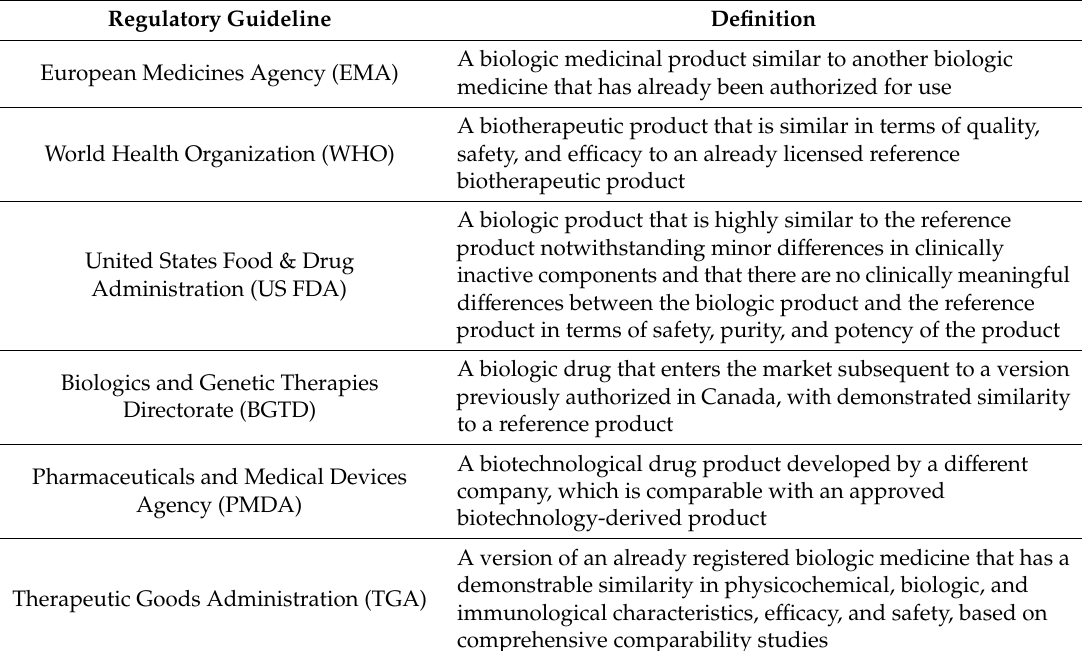
Table 1. Definition of biosimilars by major regulatory authorities